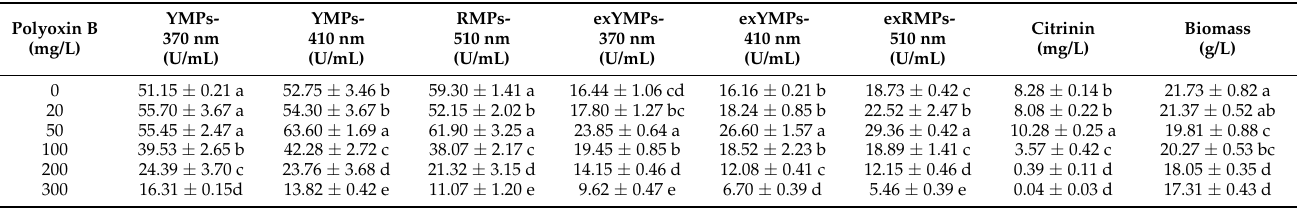
Table 2. The effect of ployoxin B on biomass, Monascus pigments and citrinin production of M. purpureus LQ-6 in submerged fermentation for 10 days at 30 ◦ C in the dark. Different letters in the same column indicate a significant difference ( p < 0.05).